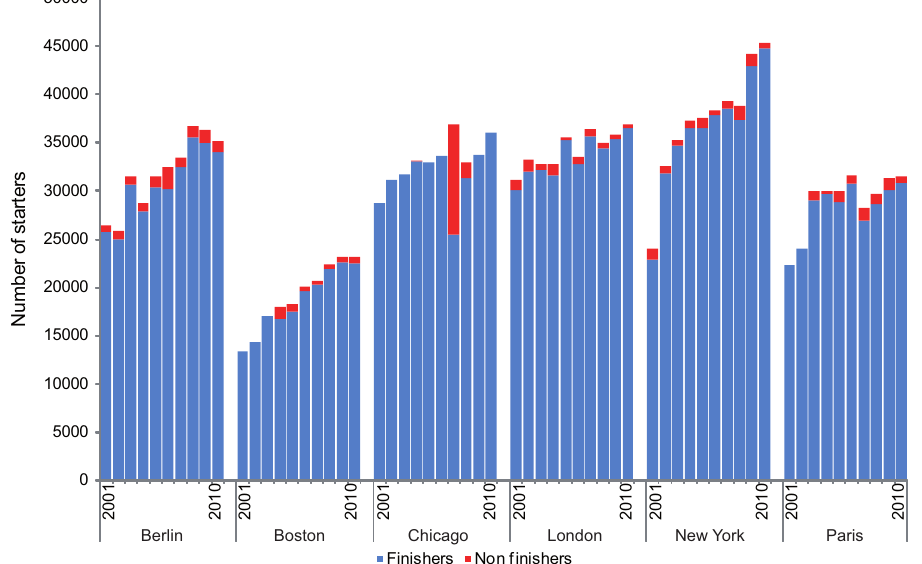
Figure 1. Number of starters and finishers by marathon and year (missing data points for Boston, Chicago and Paris marathons).